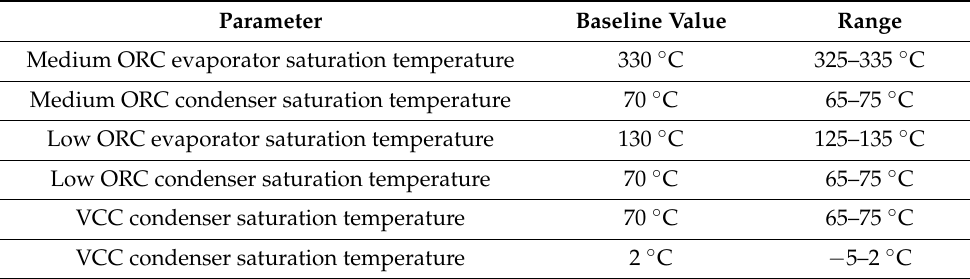
Table 3. The baseline conditions and the range of parameters considered for the sensitivity